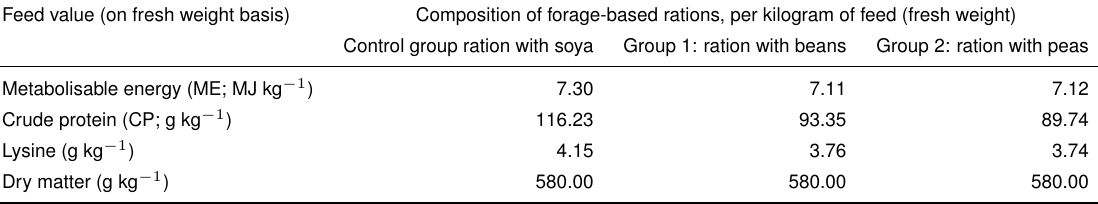
Table 4. Nutritional value of foraged-based total mixed rations for pigs, with different protein